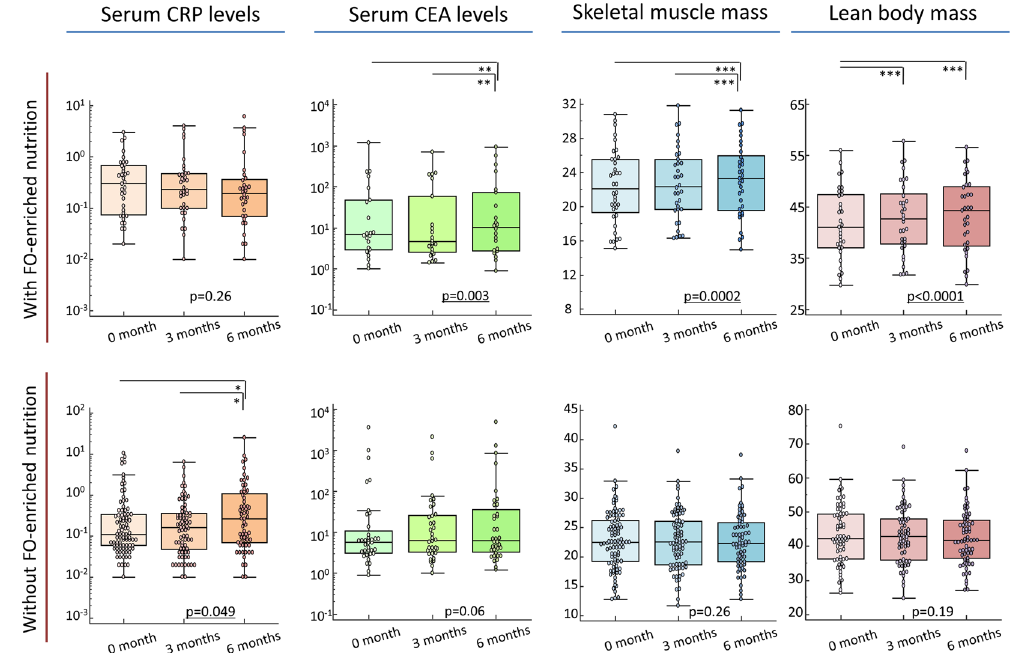
Figure 1. Chronological alterations in biochemical and physiological status during systemic chemotherapy in patients with GI cancer. (Upper line) Box plots are used to represent the biochemical (serum CRP and CEA levels) and physiological status (skeletal muscle mass and lean body mass) of GI patients who received FO- enriched nutrition during systemic chemotherapy. Serum CRP levels were not significantly changed in the FO- enriched nutrition group of patients with GI cancer (p = 0.26), and there was a significant improvement in the skeletal muscle mass and lean body mass of this group (p = 0.0002 and p < 0.0001, respectively). (Lower line) Box plots are used to represent the biochemical (serum CRP and CEA levels) and physiological status (skeletal muscle mass and lean body mass) of GI cancer patients not receiving FO-enriched nutrition during systemic chemotherapy. Serum CRP levels significantly increased (p = 0.049) along with serum CEA levels (p = 0.06). There were no significant differences in skeletal muscle mass or lean body mass (p = 0.26 and p = 0.19, respectively). Statistical analysis was performed using Friedman tests. All statistical tests were two-sided.